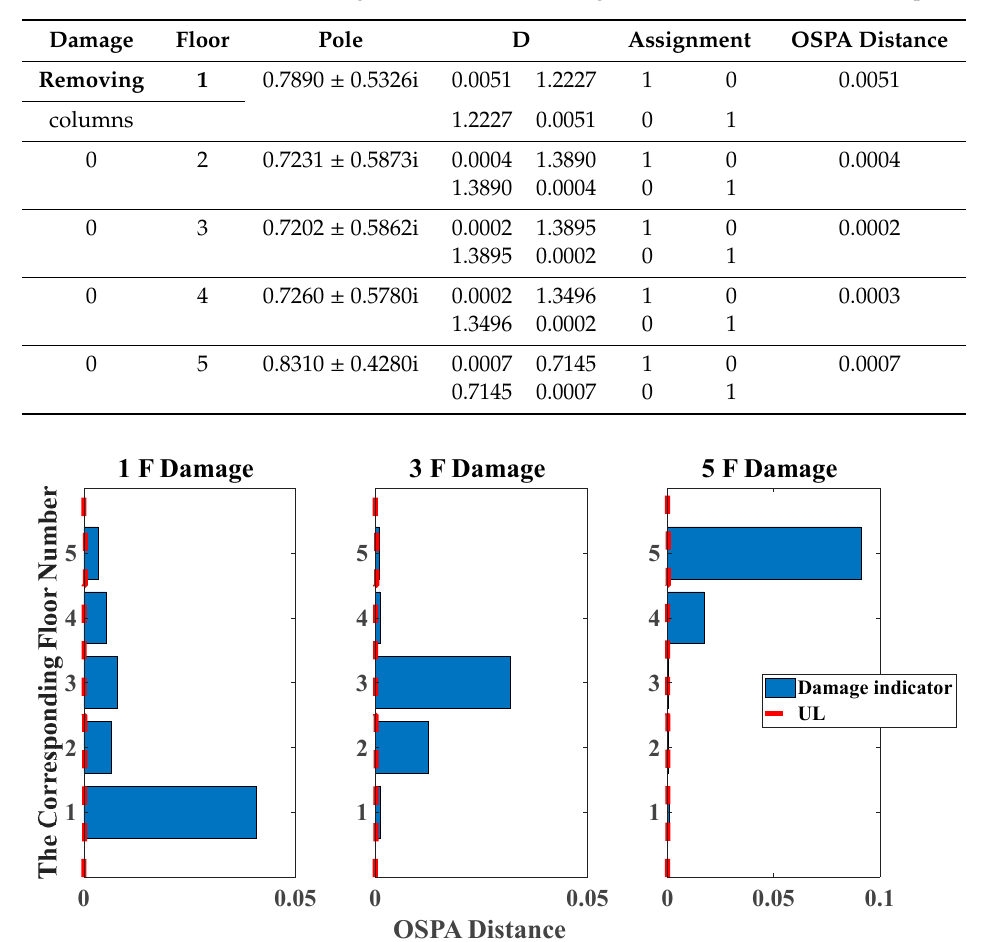
Figure 28. Damage detection results based on the OSPA distance (removing central columns, white noises excitation, autoregressive model, data length = 4000, AR order = 2, OSPA.p = 2). Two examples illustrating the impact of changing AR order on damage detection results are given in the case of removing braces and central columns on the third floor. Figures 29 and 30 show the AIC plot of the third ‐ floor response modeled with AR model. At the same time R values of various AR orders from 1 through 50 are given in Figures 31 and 32. Finally, AR order = 4 or 6 is believed to be optimal based on the AIC criterion but does not yield satisfactory identification results. In comparison, it is more reasonable to choose AR order = 2 as the model order for best damage identification. It should be pointed out that selecting the appropriate model order is crucial for the success of damage detection. Still, due to the diversity of responses and the complexity of the damage scenarios, it is difficult to give a general guideline for choosing proper AR order. Since the R ‐ value criterion is only for single floor damage scenario of the shear building structure, it is still necessary to establish a general criterion for model order selection in the future research.